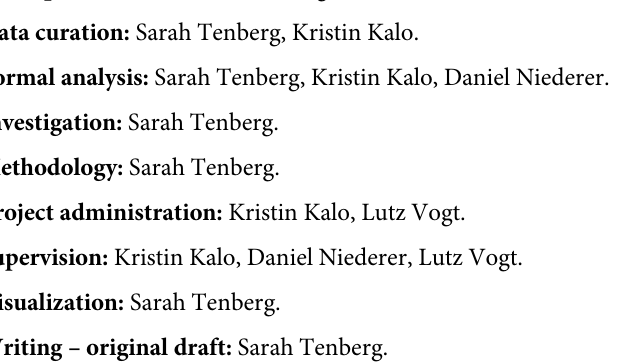
S1 Table. Data table with the mean and median values from five repetitions of extension and of the mean sound amplitude (A) and of the median power frequency (B) during the different measurement times in the control and intervention sessions, as well as the pre-post differences for the corresponding